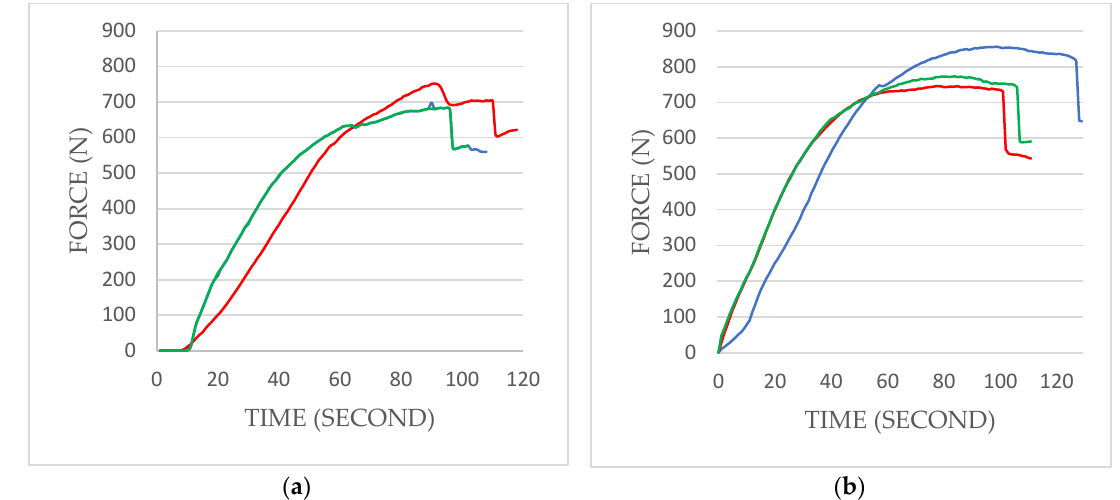
Figure 4. Single-load-to-failure test results with two different implant fixtures: ( a ) TX, ( b ) EV. Compressive load increasing at a speed of 1mm/min was applied. The peak indicates when deformation starts to occur on the implant – abutment assembly, which is the maximum breaking load. The average maximum breaking load of TX = 711 ± 36 N; EV = 791 ± 58 N.